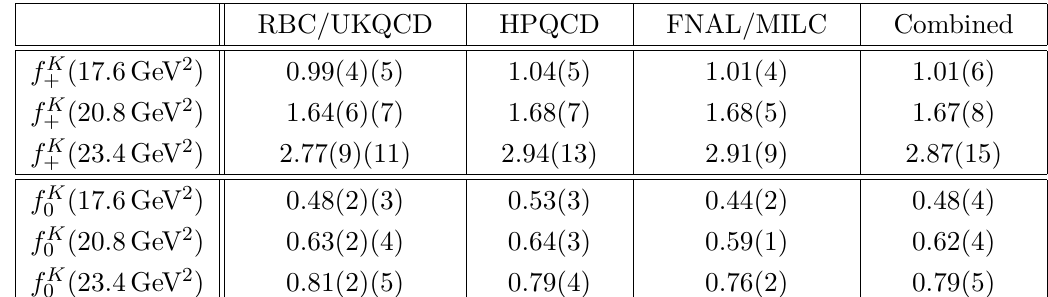
Table 2 . Mean values and uncertainties of the LQCD computations of the FFs f K tained at three selected values of q 2 from the results of the RBC/UKQCD [20], HPQCD [22] and FNAL/MILC [23] Collaborations. For the RBC/UKQCD computations the first error is statistical while the second one is systematic. The last column contains the results of the combination procedure given in eqs. (3.1)–(3.2) with ω ( k ) = 1 /N